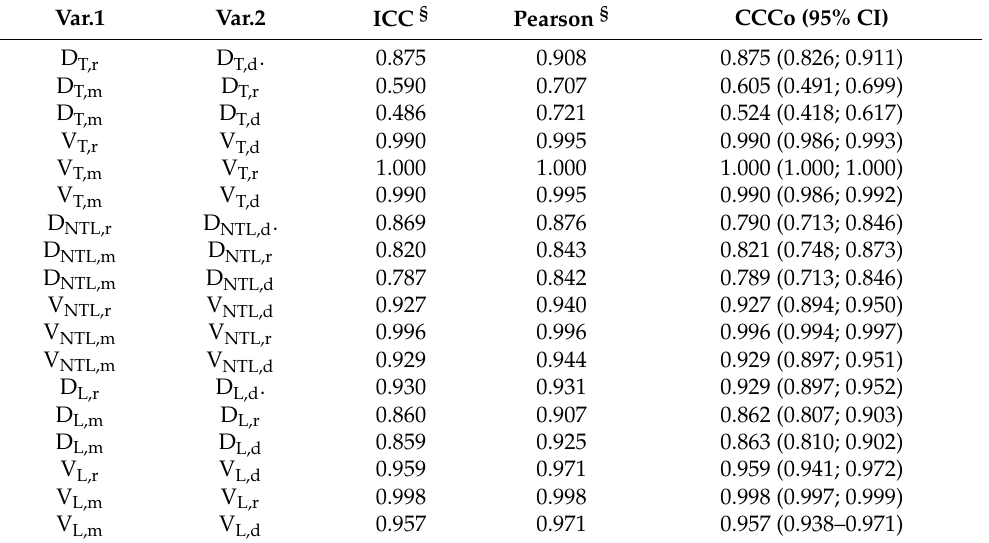
Table 2. ICC of volumes and mean absorbed doses vs. the methods of VOI delineation and propaga- tion. Ninety-five percent confidence intervals (CI) of CCCo are reported. § All values were statistically significant ( p <